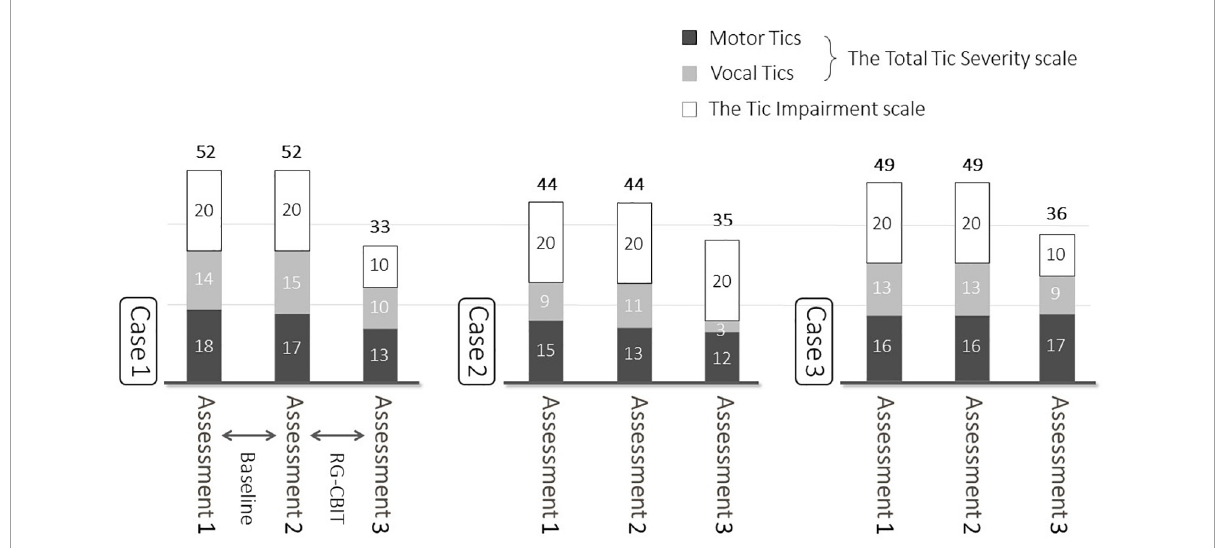
FIGURE2 Baseline and post-treatment YGTSS. At baseline, the Total Tic Severity scale score did not change. However, after the intervention, those scores decreased by 9, 9, and 3 points for cases 1, 2, and 3, respectively. The score reduced by an average of 7.0.